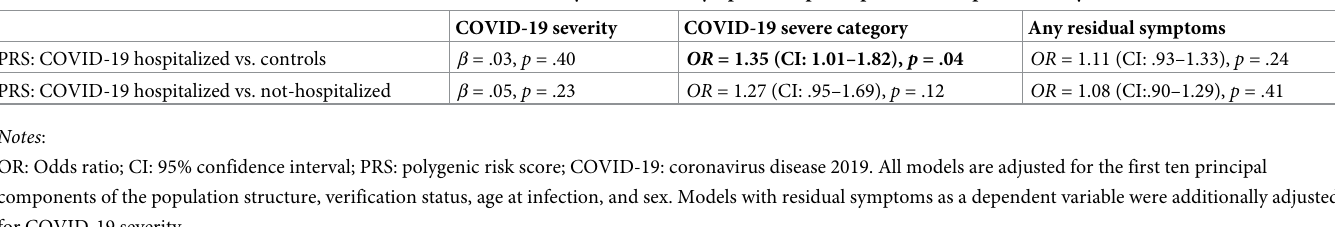
The PRS for asthma was significantly associated with COVID-19 severity in the European ancestry subsample ( β = .09, p = .01), adjusting for co-occurring obstructive airway disease diag- noses and upper respiratory disease diagnoses, Table 2. Likewise, the PRS for asthma was associ- ated with COVID-19 severe category ( OR = 1.61, [1.17–2.21]). Allergic disease PRS showed a similar pattern, significantly associating the COVID-19 severe category ( OR = 1.97, [1.26–3.07]). Associations with residual COVID-19 symptoms were not significant. There were no significant associations between coronary artery disease or type II diabetes PRS, and COVID-19 pheno- types (Table 3). The COVID-19 PRS based on the GWAS contrasting hospitalized cases vs. con- trols was significantly associated with the COVID-19 severe category in sample with European ancestry ( OR = 1.35, [1.01–1.82]), Table 4. Conversely, the COVID-19 PRS based on the GWAS contrasting hospitalized cases vs. non-hospitalized cases did not reach significance in the Euro- pean ancestry subsample. Moreover, none of the COVID-19 PRS were associated with the full range of COVID-19 severity, nor the presence of any residual symptoms.